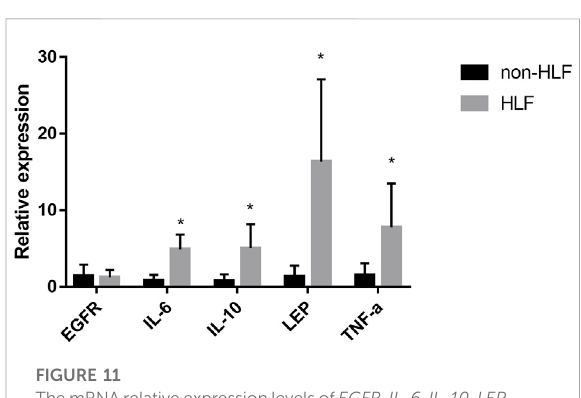
FIGURE 11 ThemRNArelativeexpressionlevelsof EGFR,IL-6,IL-10,LEP , and TNF- α in the LFH( n = 6) and normal LF groups ( n = 6) were veri fi edbyqRT-PCRoperatedin40cycles,andtheexpressionwas calculated using the 2 − ΔΔ CT method. The expression of IL-6, IL-10, LEP , and TNF- α was signi fi cantly higher in the LFH group than in the normal LF group (*, p < 0.05) but there was no difference in EGFR